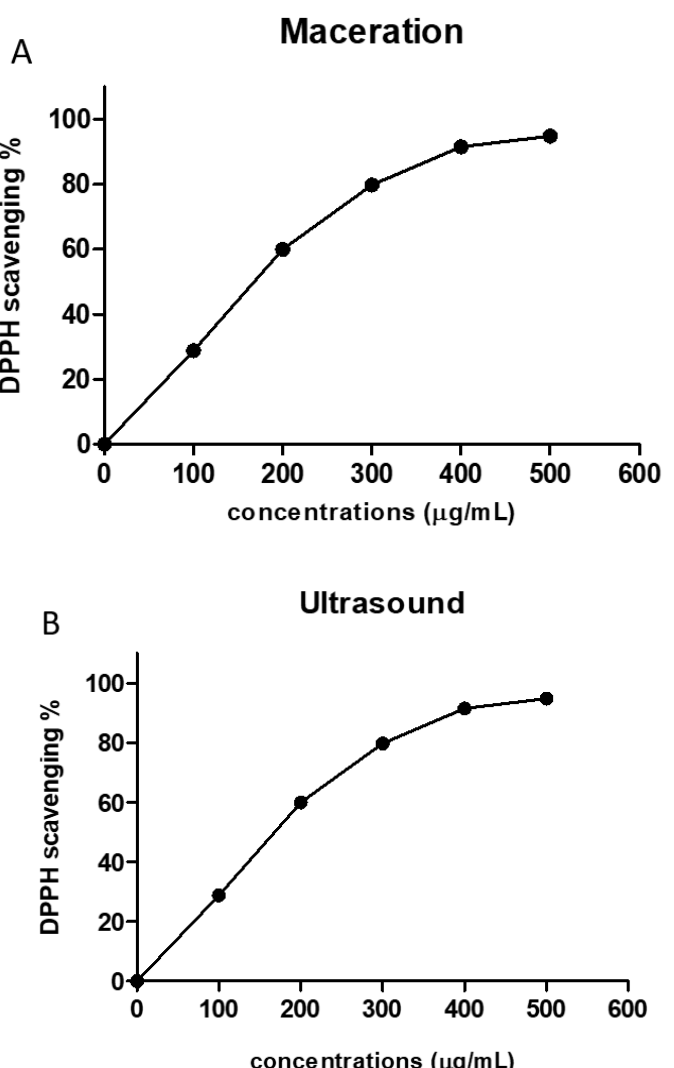
Figure 1. Antioxidant activities of P. tetragonolobus extracts according to the concentration of extract. DPPH scavenging activity of P. tetragonolobus extracts at different concentrations using Maceration ( A ) and ultrasound-assisted extraction ( B ) techniques. Each curve has been plotted using the means ± SD ( n =